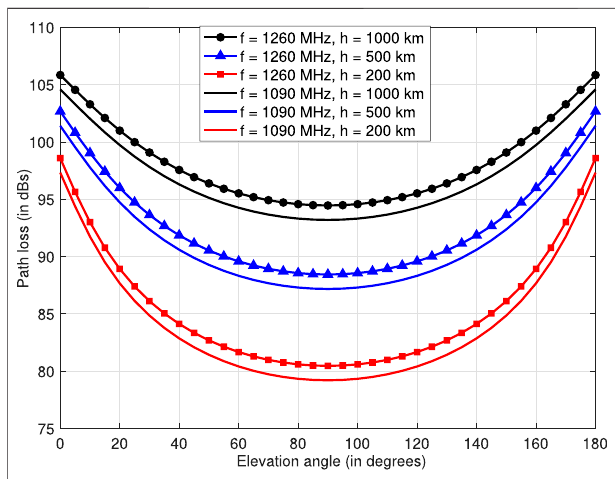
FIGURE 8 | Path loss for the satellite-to-eVTOL link in LEO for different frequencies, altitudes, and elevation angles.